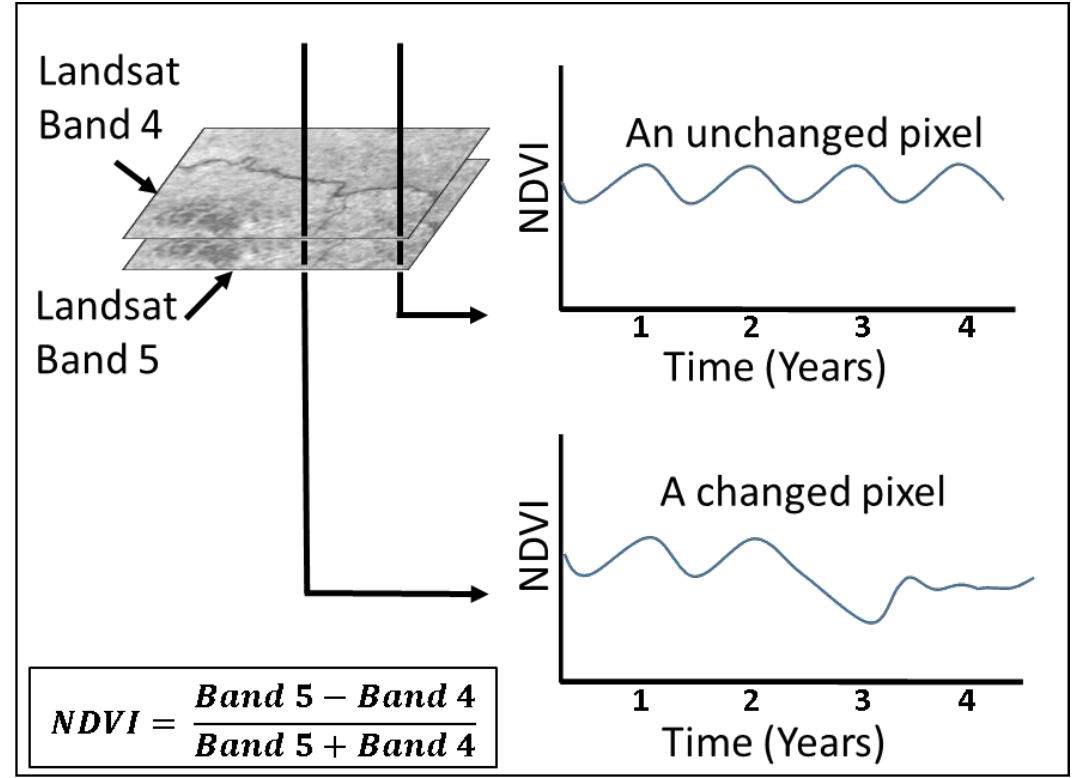
Figure 1. Conceptual diagram of the creation of Landsat time series (LTS) analysis inputs. For each pixel, brightness values for a user-specified combination of layers is measured for each scene in the record (for Landsat 8, a new image is acquired every 16 days). Normalized Di ff erence Vegetation Index (NDVI), a commonly-used vegetation index, can be calculated for each scene from Landsat 8’s bands 4 and 5, and plotted against time. The properties of the resulting time series can be assessed to identify changes through time.